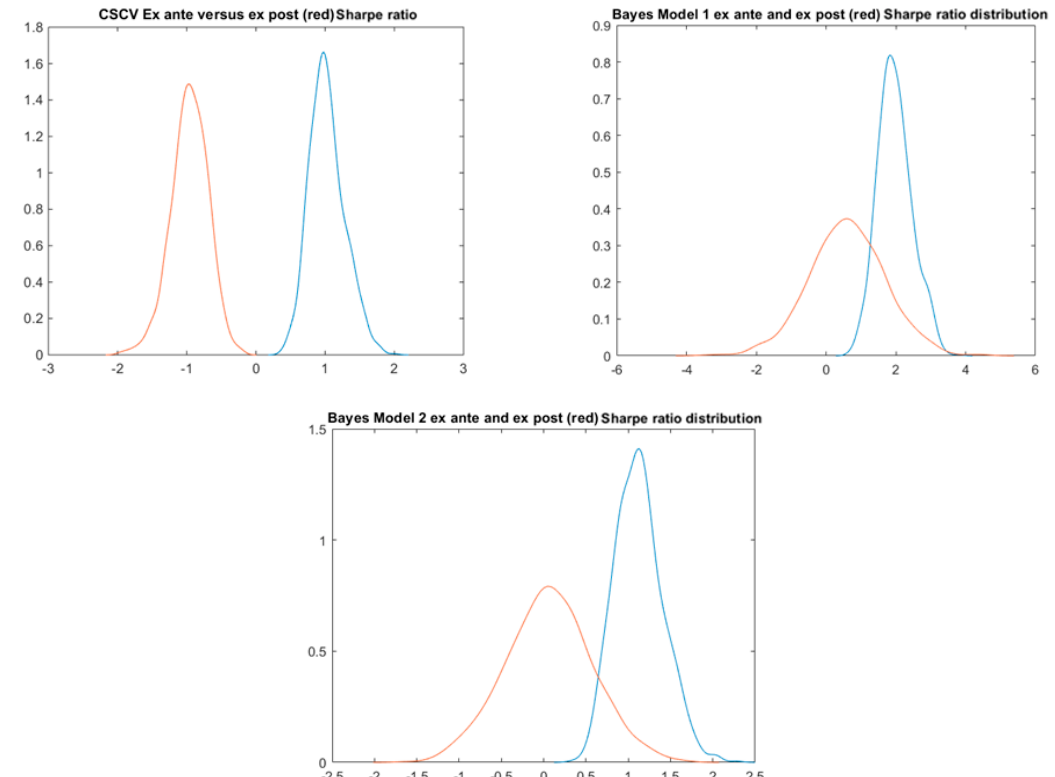
Figure 21. The simulations of the ex ante and ex post SR probability densities.